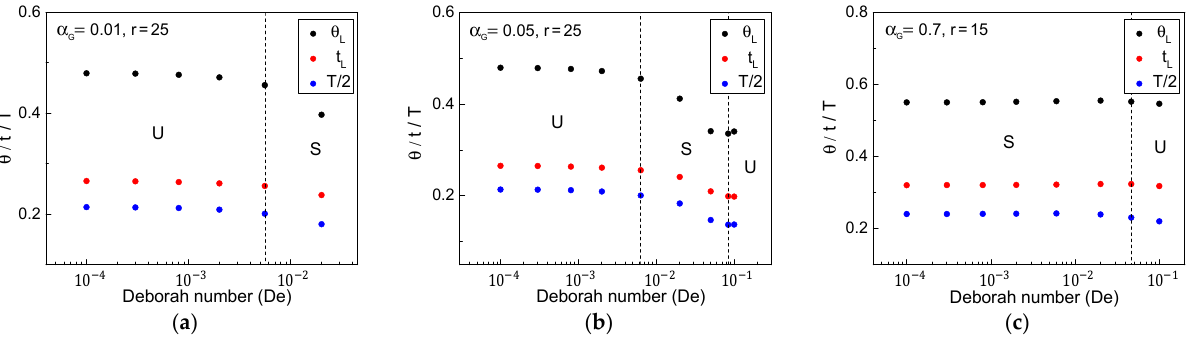
θ ), and L θ ), and L